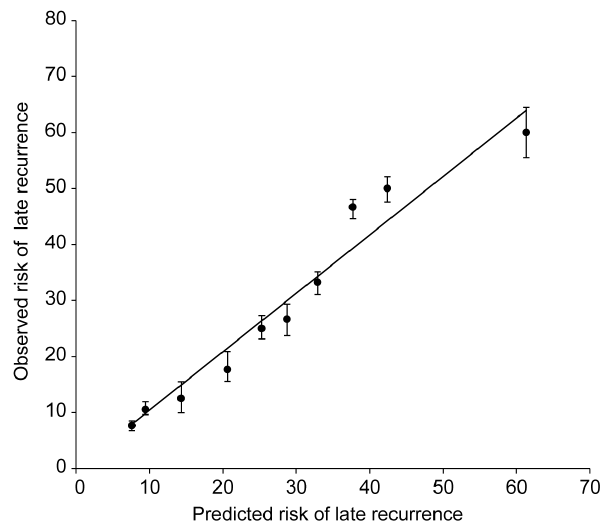
Figure 3. Calibration chart for predicted versus observed risk of late recurrence after curative resection of HCC. The predicted risk of recurrence calibrated well with the observed risk, with a correlation coefficient of 0.873 ( P , 0.001).HCC, hepatocellular carcino- ma.